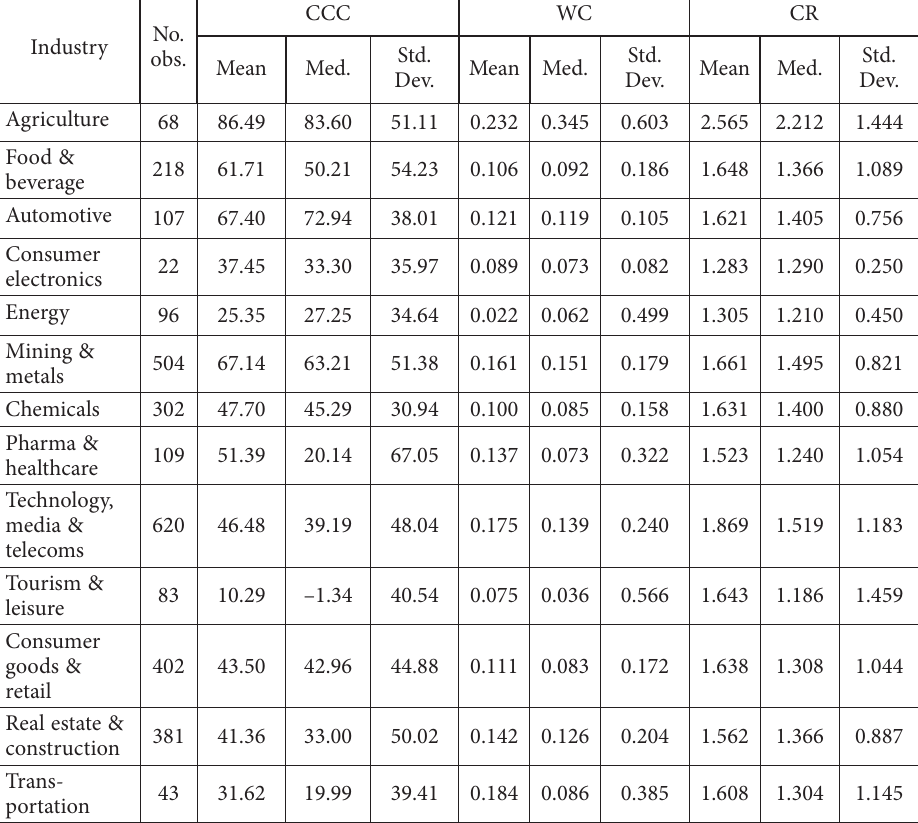
Table 5. CCC, WC and CR distribution according to industry (source: own elaboration)